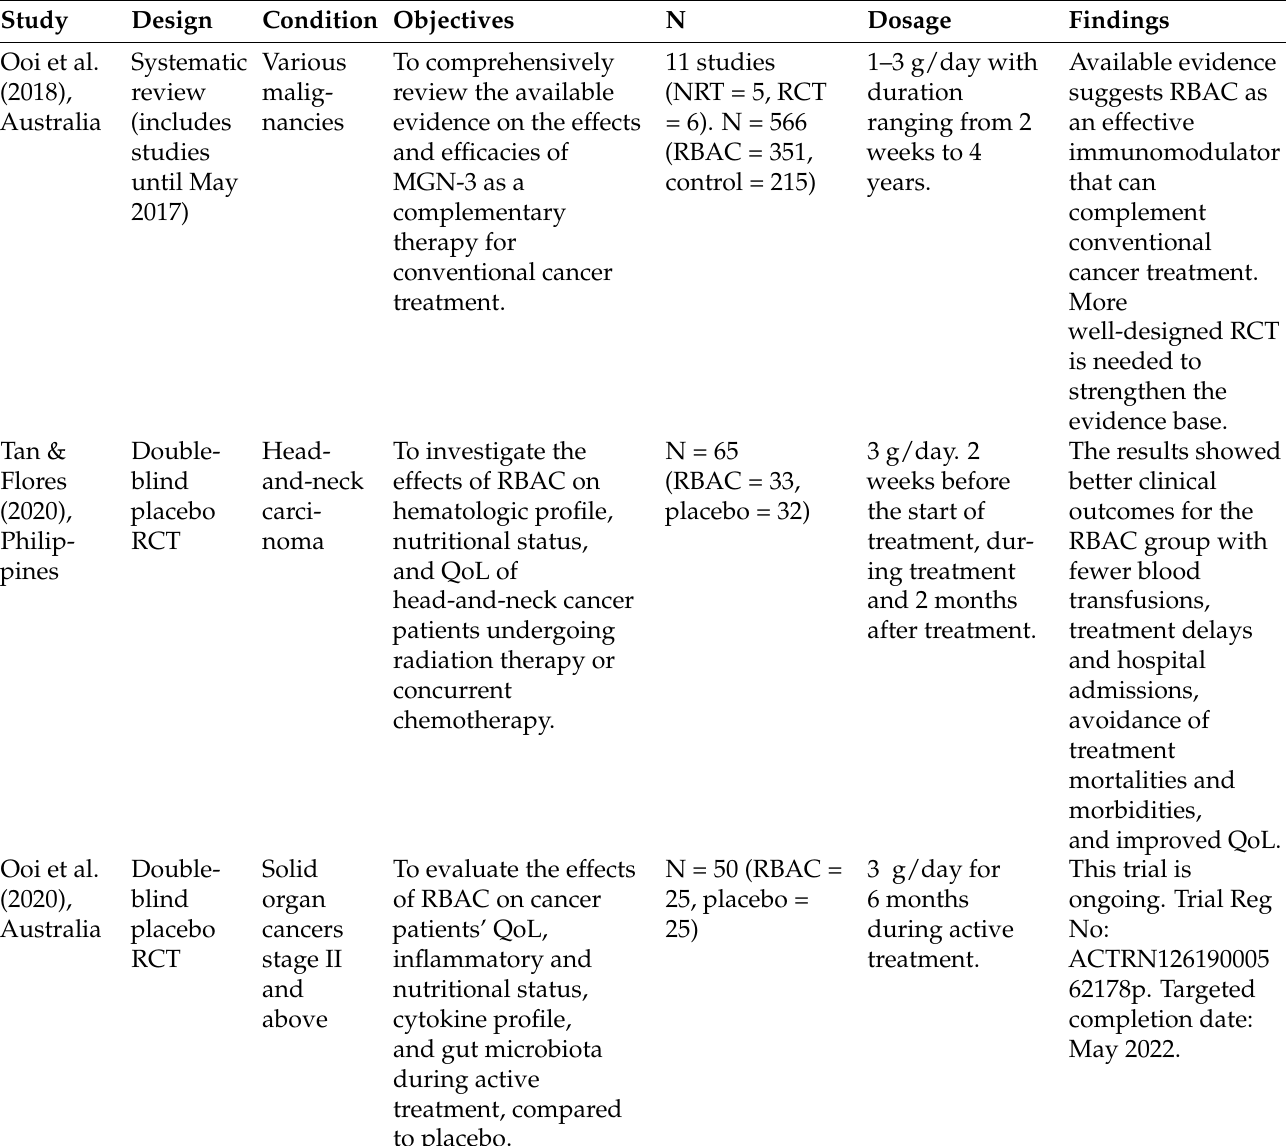
Table 1. Summary of systematic reviews and recent clinical trials evaluating the effects of RBAC on cancer